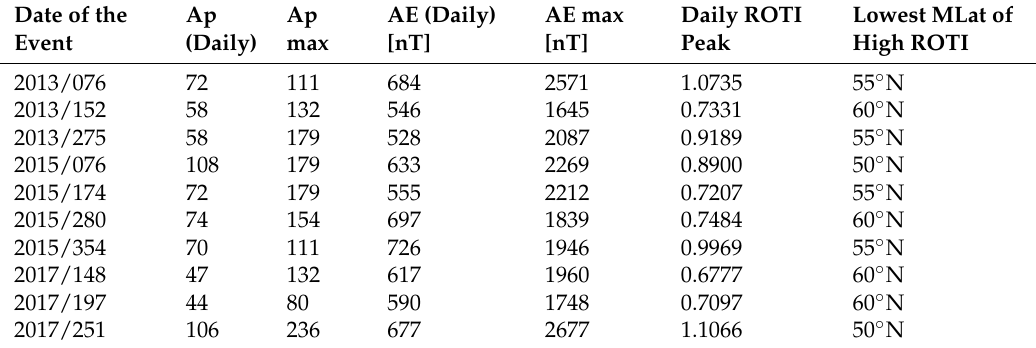
Table 3. High Ap and AE values compared with ROTI behavior (maximum value and equatorward